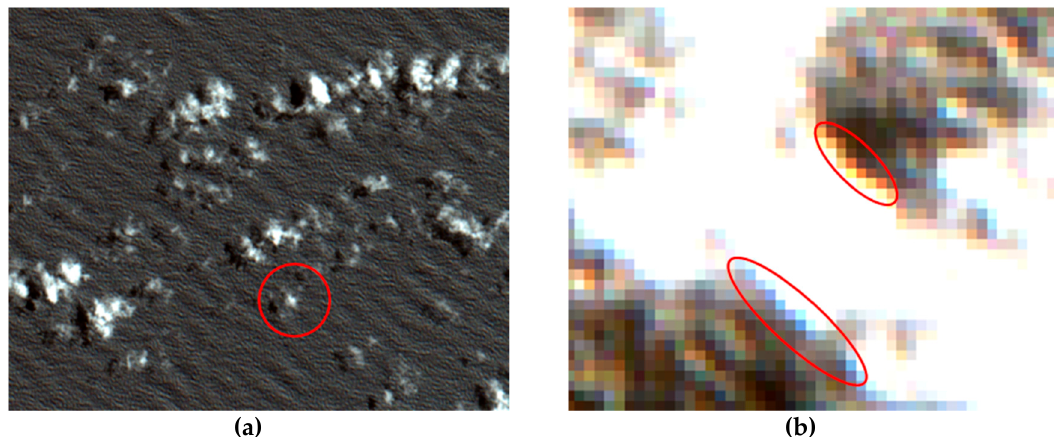
Figure 9. The objects in Sentinel-2 MSI data that can produce false alarms: ( a ) small clouds; ( b ) cloud edges of high contrast. The size of each pixel is 10 × 10 metres.